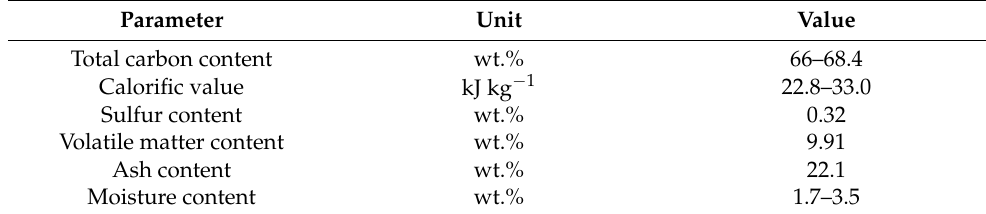
Table 3. Selected physical and chemical properties of soot.